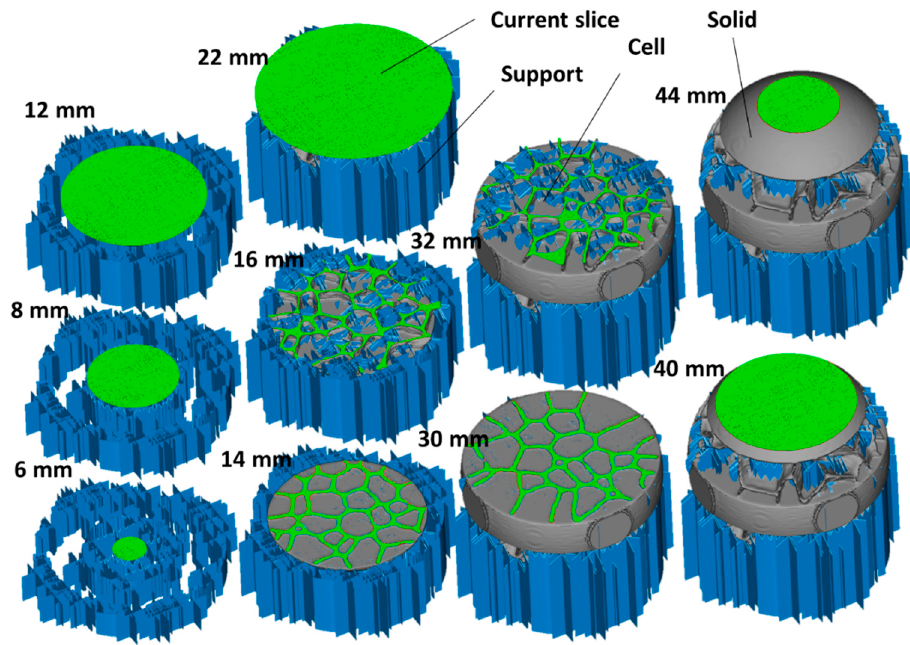
Figure 12. Slicing step showing different depth views of the Voronoi–Monte Carlo cellular structure prior manufacturing using stereolithography.